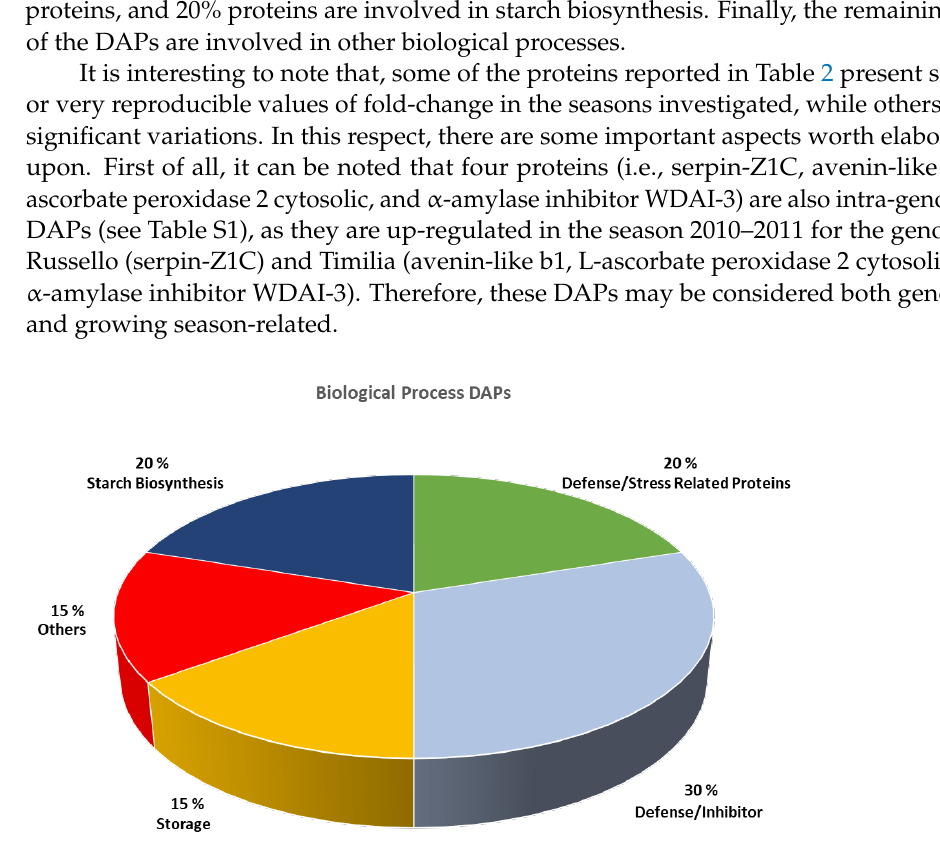
Figure 1. Pie chart showing the distribution of biological processes in which are involved the differential abundant proteins observed across the investigated genotypes.